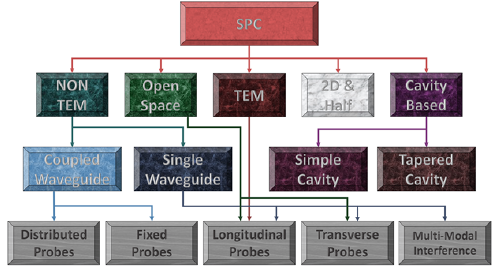
FIGURE 1. Spatial Power Combiners